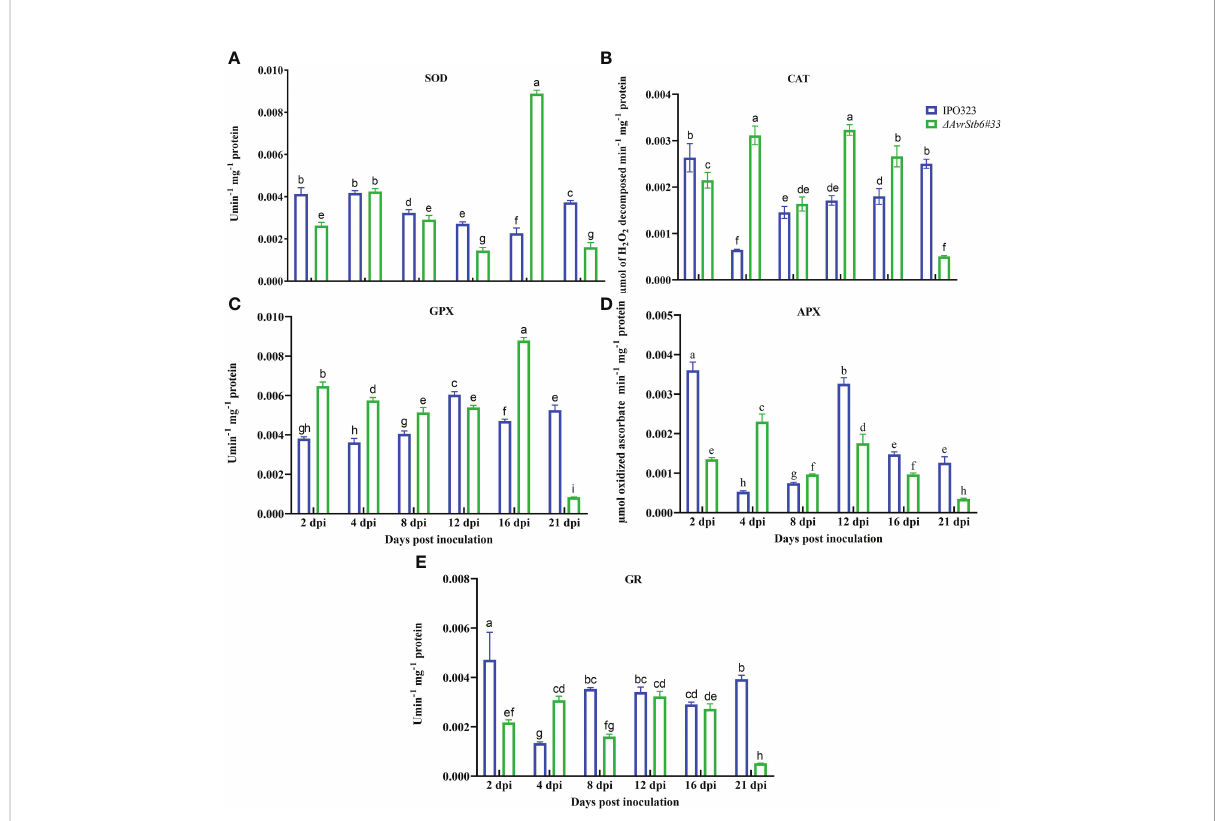
FIGURE 7 AvrStb6-Stb6 interaction manipulates the activities of fi ve enzymatic antioxidant agent. Activities of fi ve antioxidant enzymes: (A) superoxide dismutase (SOD), (B) Catalase (CAT), (C) Guaiacol peroxidase (GPX), (D) Ascorbate peroxidase (APX), and (E) Glutathione reductase measured spectrophotometrically following infection of cv. Sha fi r by WT IPO323 or D AvrStb6#33 strains. Data are indicate as mean ± SD (Standard Deviation) of four biological samples from one independent experiment. Different lowercase letters indicate statistically signi fi cant differences (P ≤